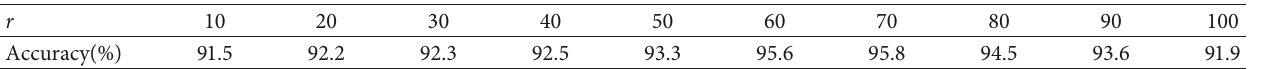
Table 5: Classification